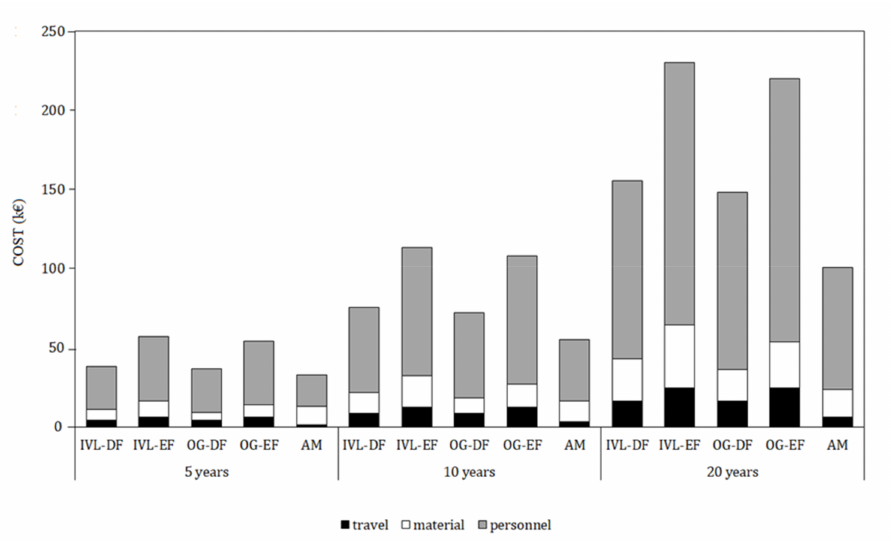
Figure 4. Monetary costs (EUR) of the monitoring systems, i.e., passive monitoring with either IVL (IVL) or Ogawa (OG) sensors, and active monitoring (AM) for deciduous (DF) and evergreen (EF) forests over three time windows, i.e., 5, 10, and 20 years of